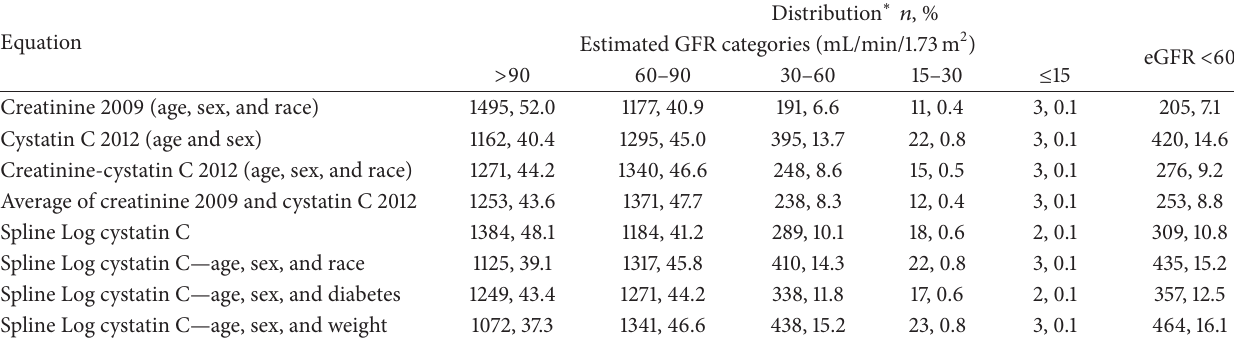
Table 3: Distribution of study population by mean estimated GFR